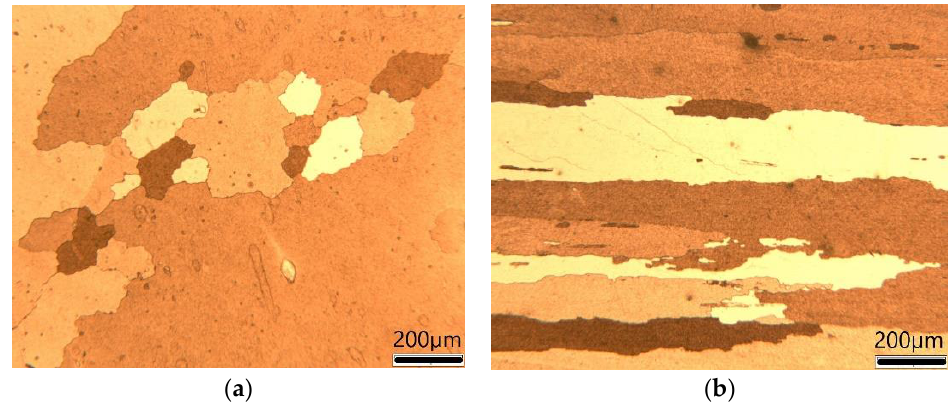
Figure 3. Optical micrographs of a PM2000 sample where ( a ) shows a transverse section and ( b ) depicts a longitudinal section.